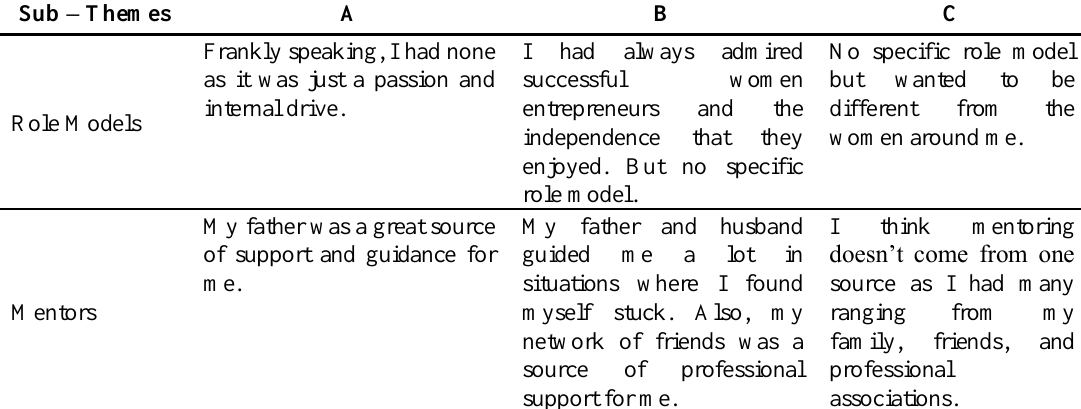
Table.4. Women’s Entrepreneurial